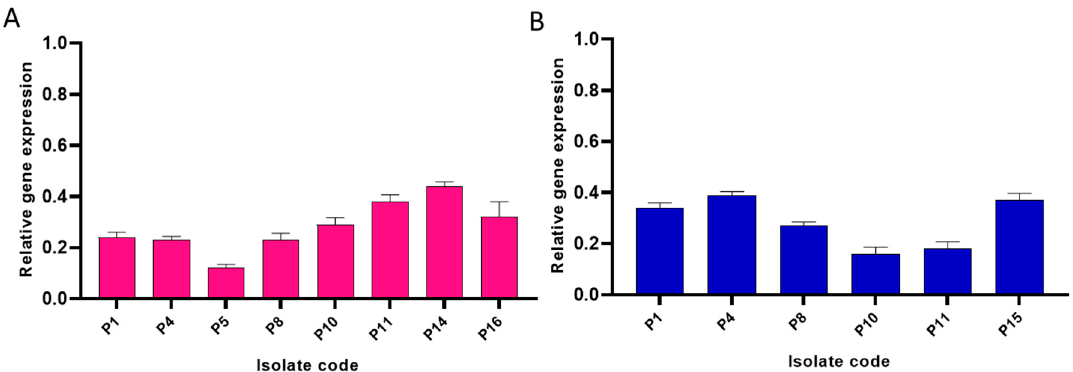
Figure 4. Bar chart showing downregulation of the expression of ( A ) las I and ( B ) las R genes. In the tested isolates by combinatorial treatment with catechin and gallic acid.